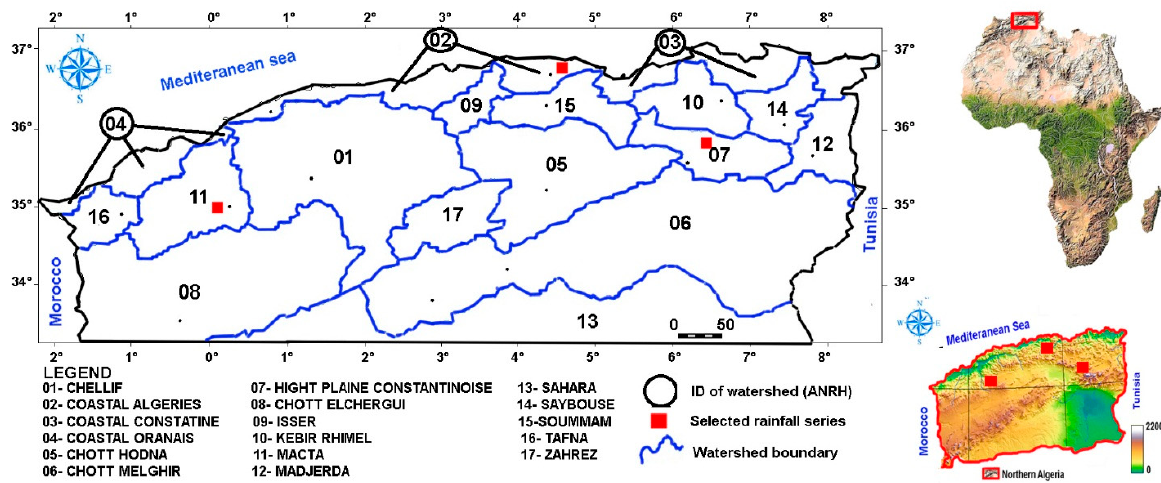
Figure 3. Northern Algeria and selected rainfall series used in the analysis.